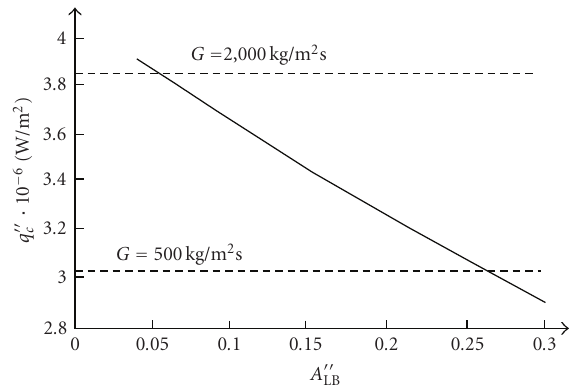
Figure 8: Typical calculated values of critical heat flux, compared against experimental data for subcooled and low-quality boiling of water at 4.5 MPa